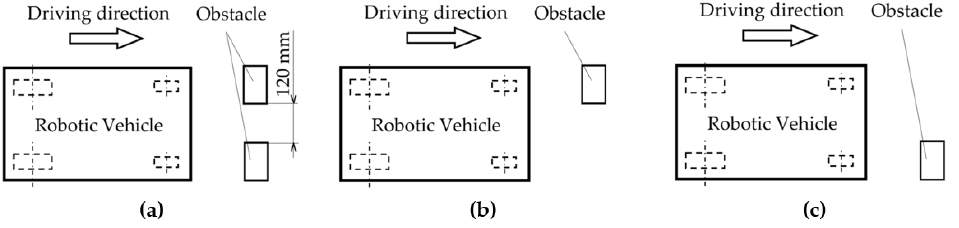
Figure 10. Obstacle dimensions.